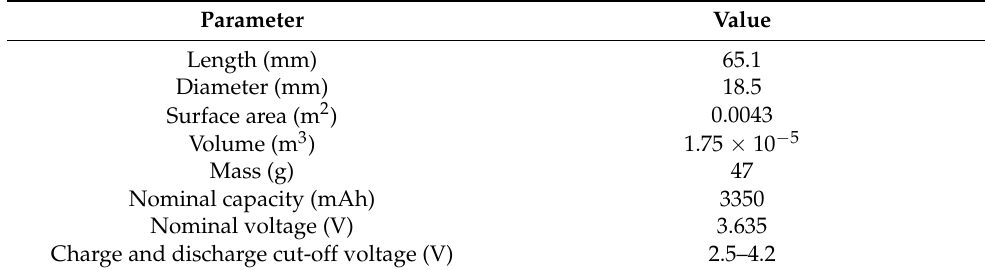
Table 1. The parameters of the battery samples.